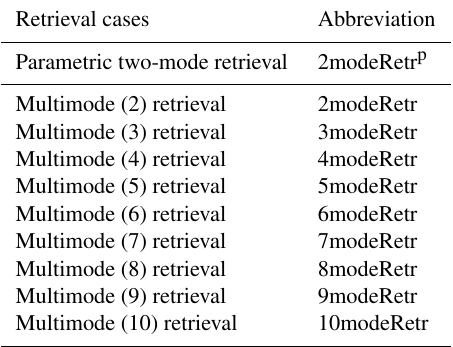
Table 3. Abbreviations for different retrieval